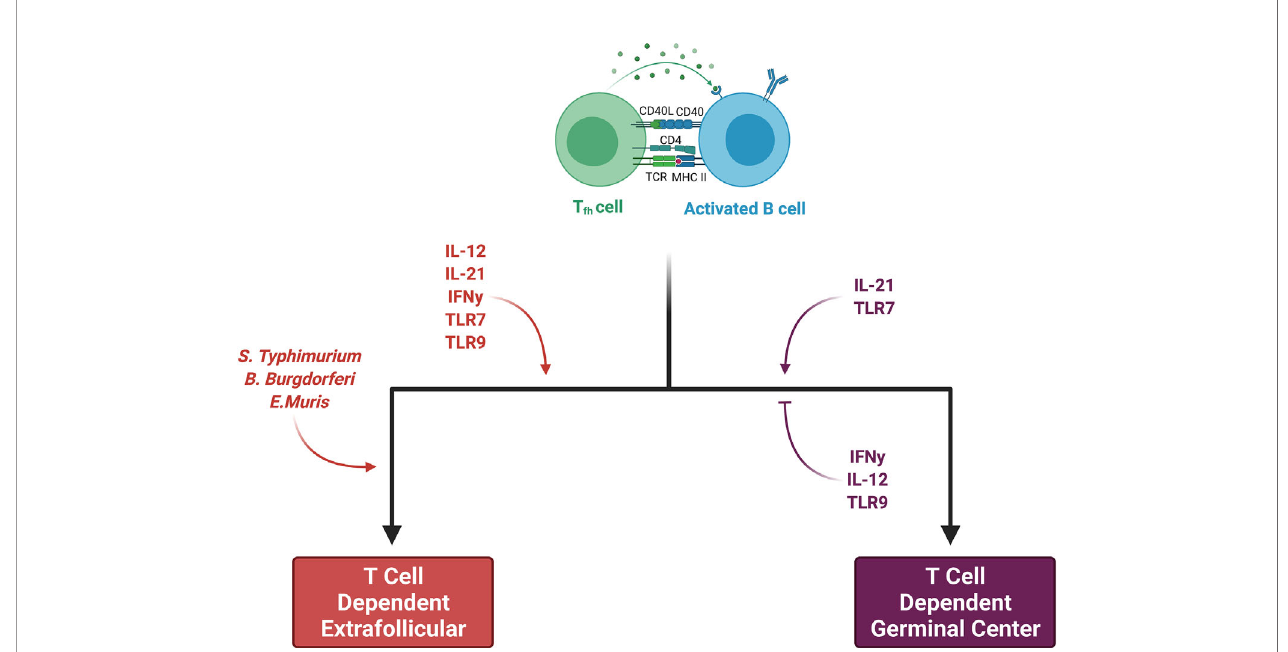
FIGURE 3 | Factors skewing responses toward either germinal center or extrafollicular pathways. Both pathogen and host factors contribute to a B cell ’ s decision between an extrafollicular (EF) and germinal center (GC) response. Certain bacteria promote an EF response through collapse of secondary lymphoid organ (SLO) architecture. While IL-21 and TLR7 may promote both EF and GC responses, IL-12, IFN-y, and TLR9 all favor EF responses. IL-12 suppresses Tfh development while favoring short-lived ASC production. INF-y may have the same effects on Tfh suppression. TLR9 clearly stimulates EF responses, whereas it may inhibit GC responses, at least in autoimmune diseases. Figure created with